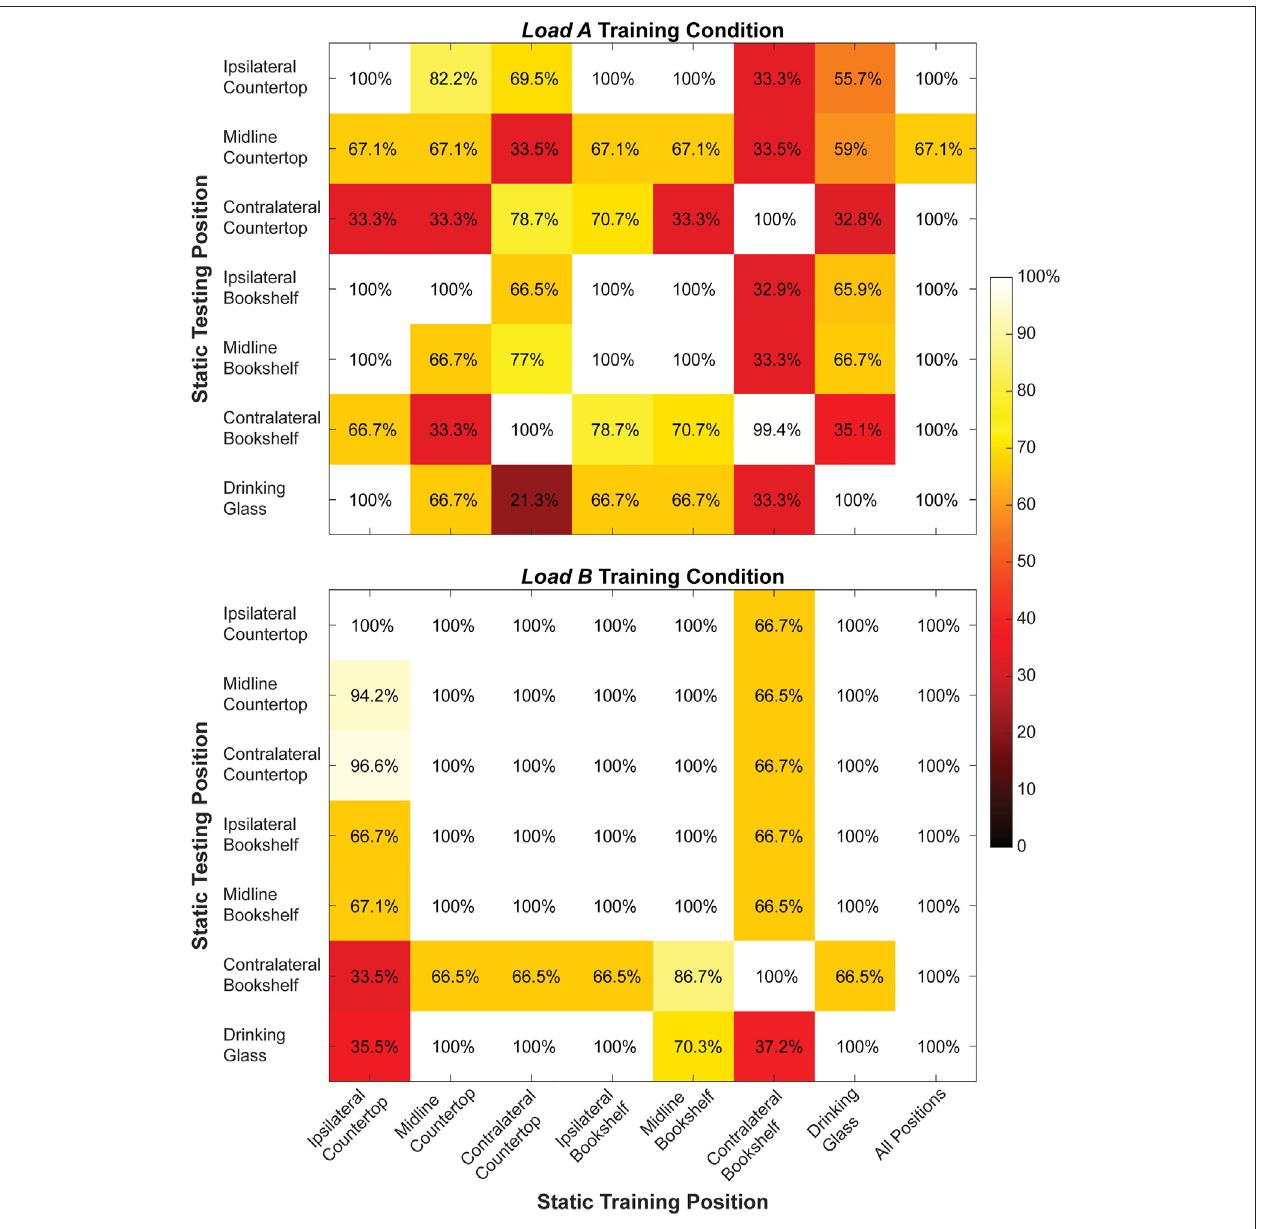
FIGURE 5 | Classi fi cation accuracy (%) for the right arm when training and testing each of the static arm positions individually and from all static arm positions collectivelyduringthe loadA and loadB trainingconditions.Valuesshowninthemaindiagonalrepresenttheintrapositionclassi fi cationaccuracies,whiletheoff-diagonal values represent the interposition classi fi cation